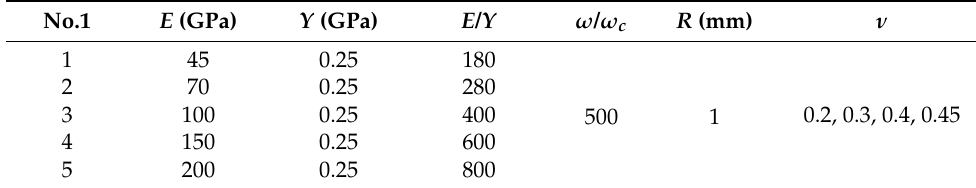
Figure 3. Finite element mesh and boundary conditions. Table 2. Material properties in the first group.